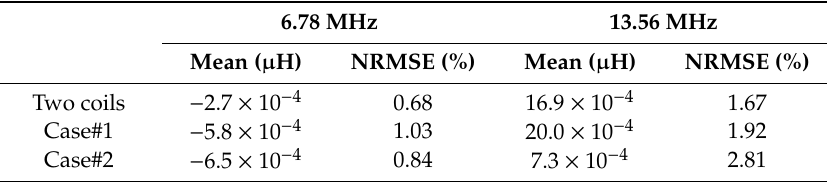
Table 3. Mean and normalized root-mean-square error (NRMSE) of difference between the results of measurement and the proposed method for Figures 8 and 9.